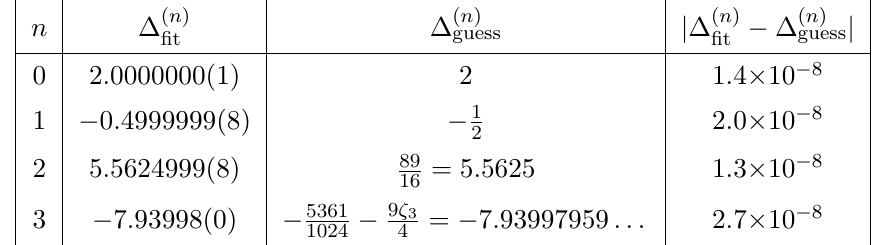
Figure 11 . Plot of (cid:1) L =4 ;S =1 as a function of h : the dots correspond to the numerical data reported in appendix D.2, table 9, while the solid line and the dashed line represent the strong coupling expansion (5.25) and the weak coupling Pad(cid:19)e approximant (5.24) respectively.